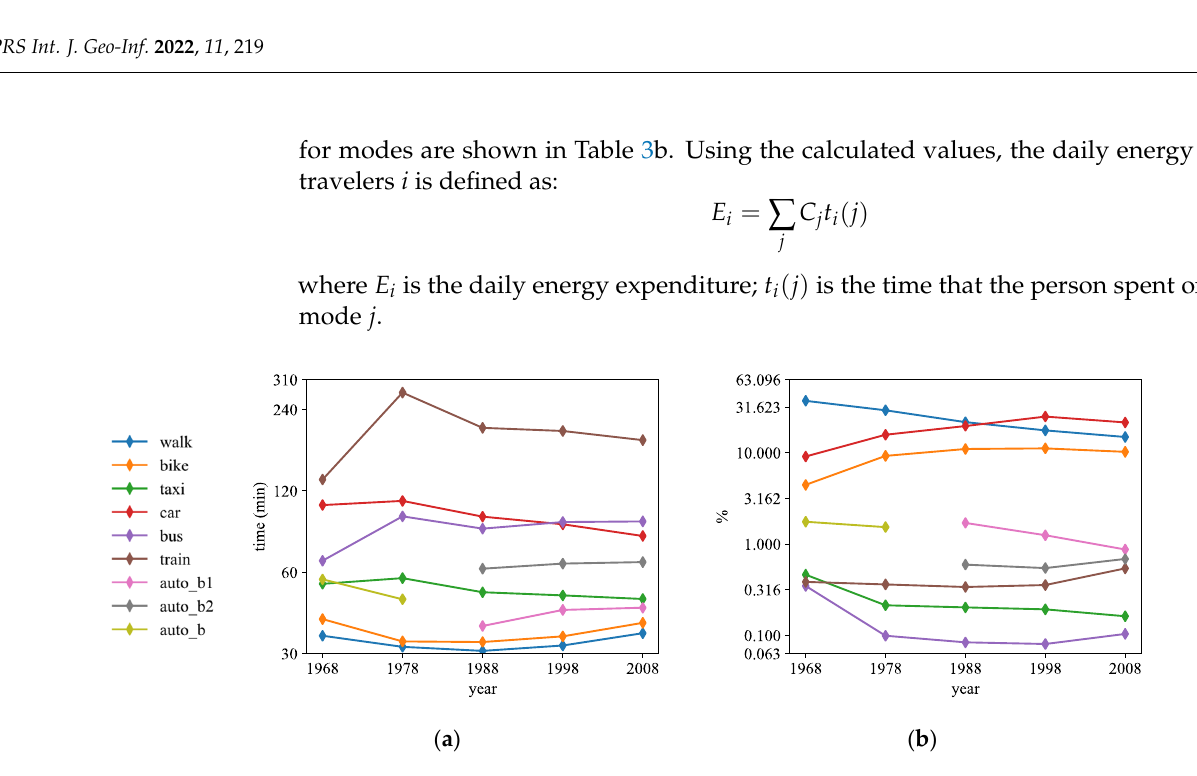
Figure 14. Unstable travel time and travel modes share (auto_b is the motorized bike for 1968 and